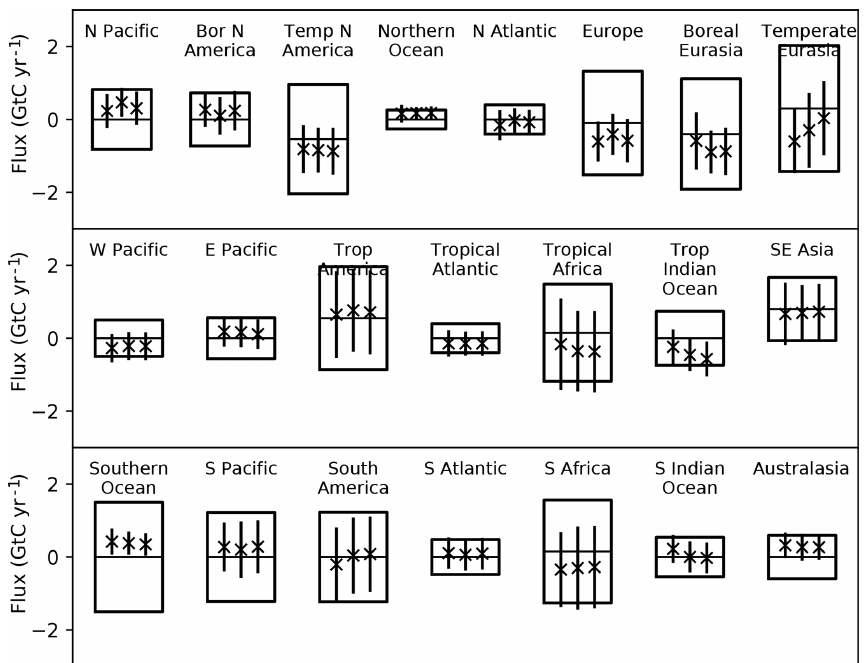
Figure 2. Prior and posterior uncertainties for regional fluxes from TransCom following Gurney et al. (2002). The centre line of each box shows the prior estimate of the mean while the box limits show the ± 1 σ uncertainties. The three bars show the mean (marked with “x”) and ± 1 σ uncertainty denoted by the length of the bar. The uncertainty is that of the ensemble including both the uncertainty for each model and the dispersion among model means. The left bar shows the equally weighted case, the middle bar the case for the p( H i | y ) and the right bar the case with covariance of residuals